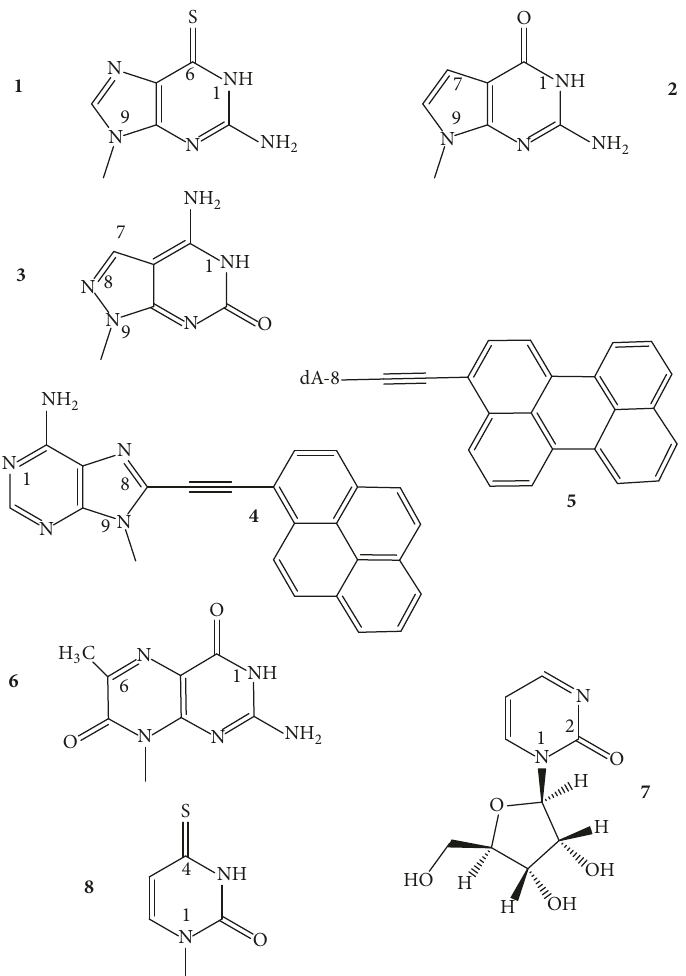
Figure 13: Structures of 6-thioguanine ( 1 ); 7-deazaguanine ( 2 ); 8-aza-7-deaza- iso guanine ( 3 ); pyrene ( 4 ) and perylene ( 5 ) tethered to C8 of guanine; 6-methyl-isoxanthopterin ( 6 ); zebularine or 2-pyrimidinone-riboside ( 7 ); and 4-thiouracil ( 8